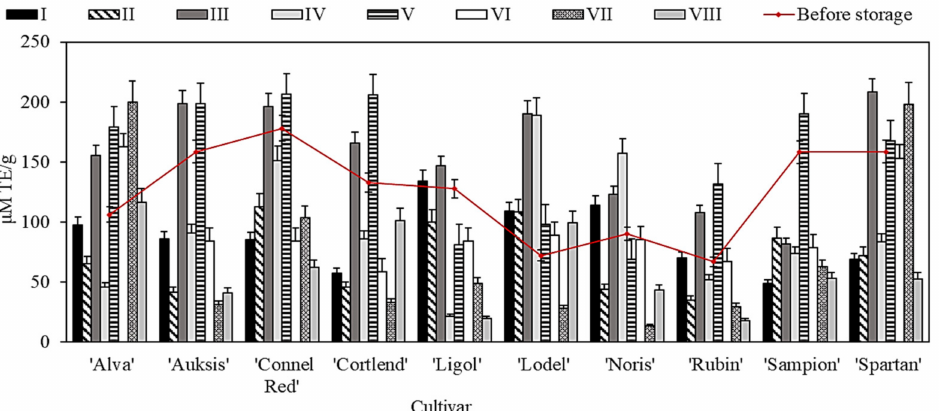
Figure 9. Antioxidant activity of apple peel samples before and after storage in controlled atmosphere evaluated via the DPPH free radical scavenging